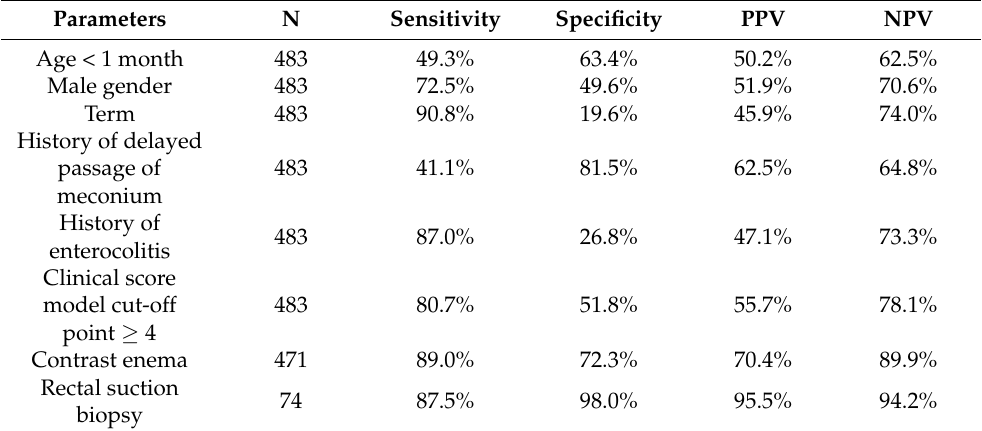
Table 6. Sensitivity, specificity, PPV, and